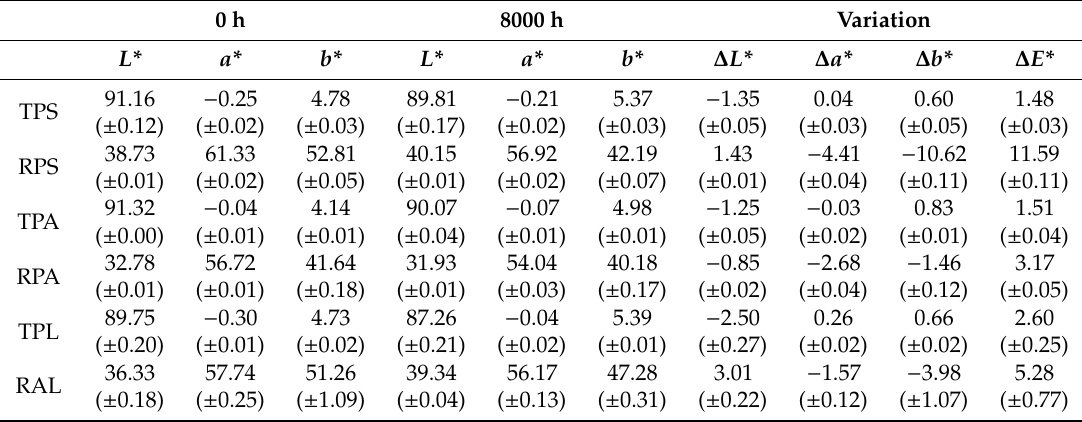
Table 3. Average values and standard deviation for color coordinates ( L *, a *, b *) of the test samples, before and after 8000 h artificial aging, and respective